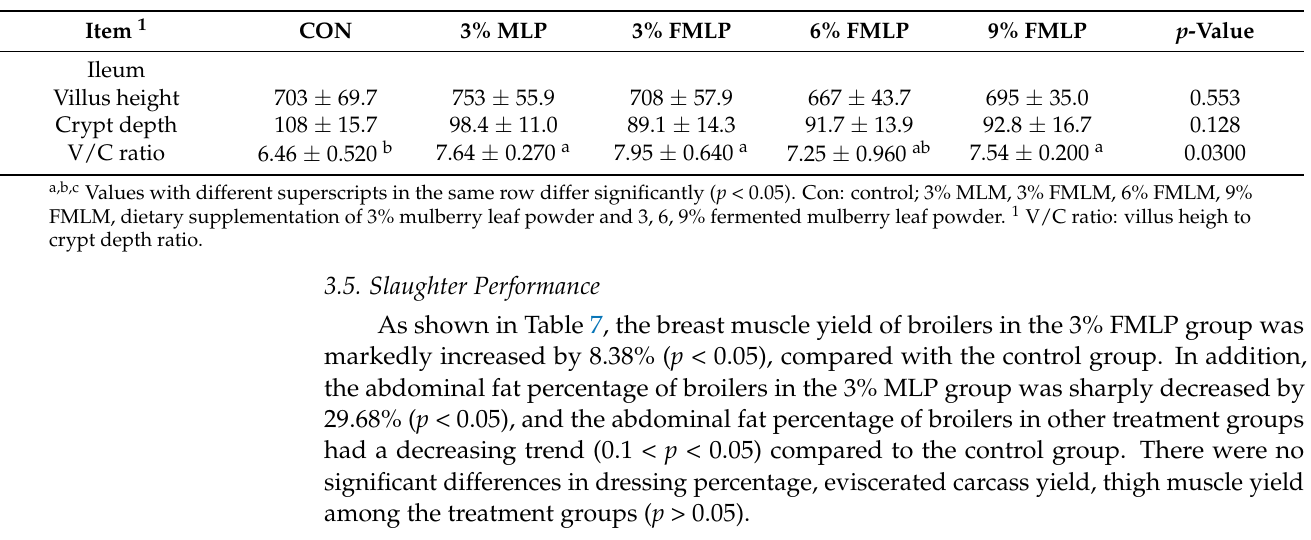
Table 7. Effects of FMLP on slaughter performance of broilers.